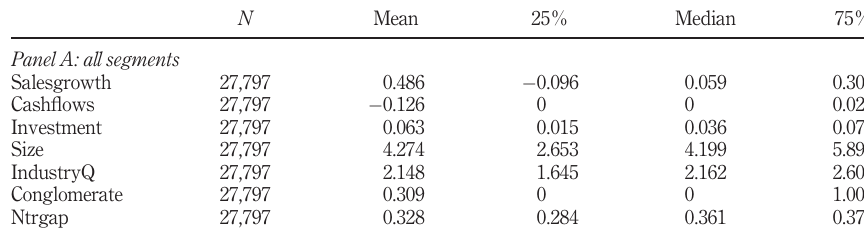
Panel B: comparison between conglomerate segments and single-segment fi rms